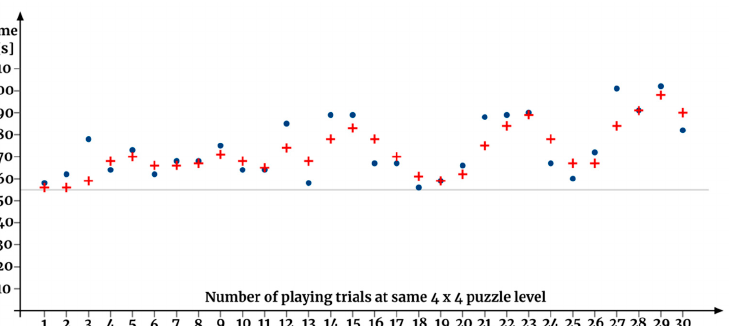
Figure 4. Adaptation of time frame according to level completion time for player type 2. Blue dots represent the level completion time; red crosses represent time frames adapted to the player.